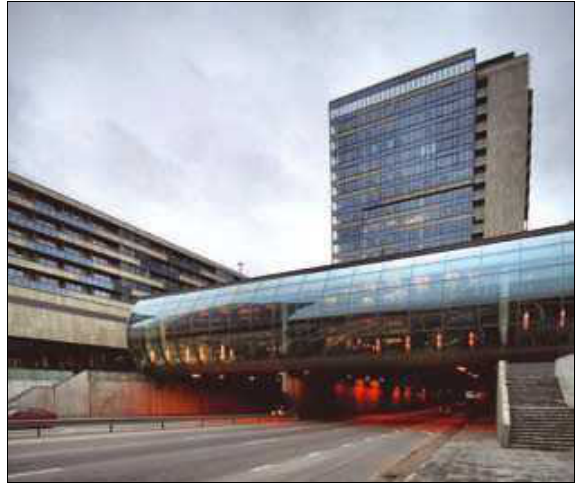
18 pav. Dau­giafu­nkcis kompleksas „Vilniau­s var­tai“ (ar­chit. r­. bimba) Fig. 18. Mu­ltifu­nction complex “Vilniau­s